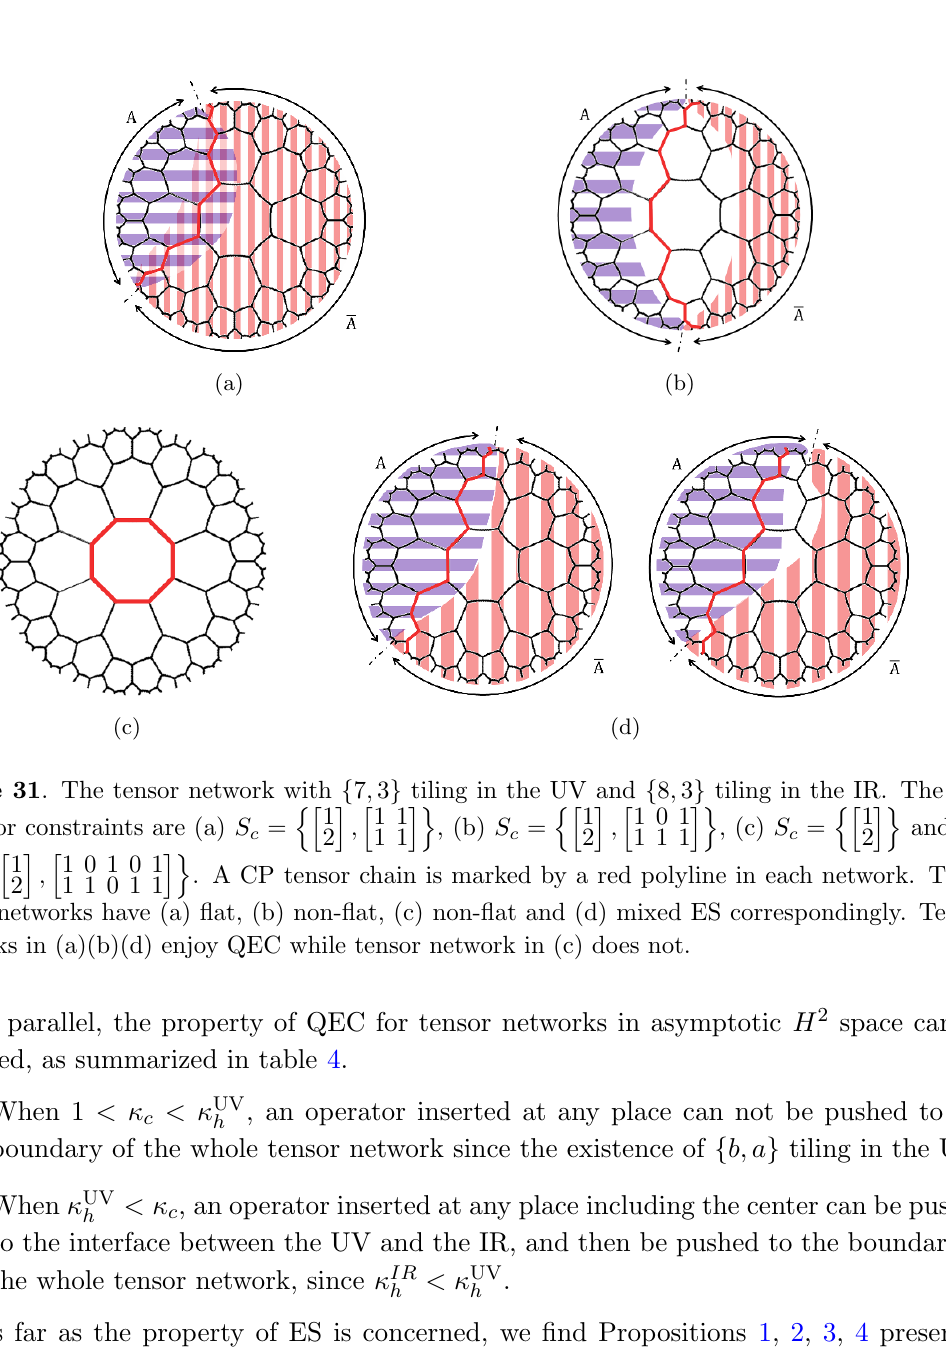
nh 1 i h 1 1 io ; , (b) S c = 2 1 1